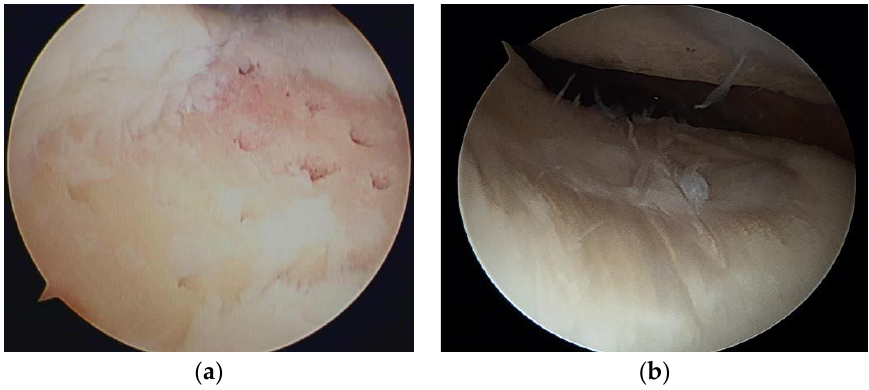
Figure 2. ( a ) Microfracture of a cartilage defect of the trochlea; ( b ) second-look arthroscopy 2 years later.